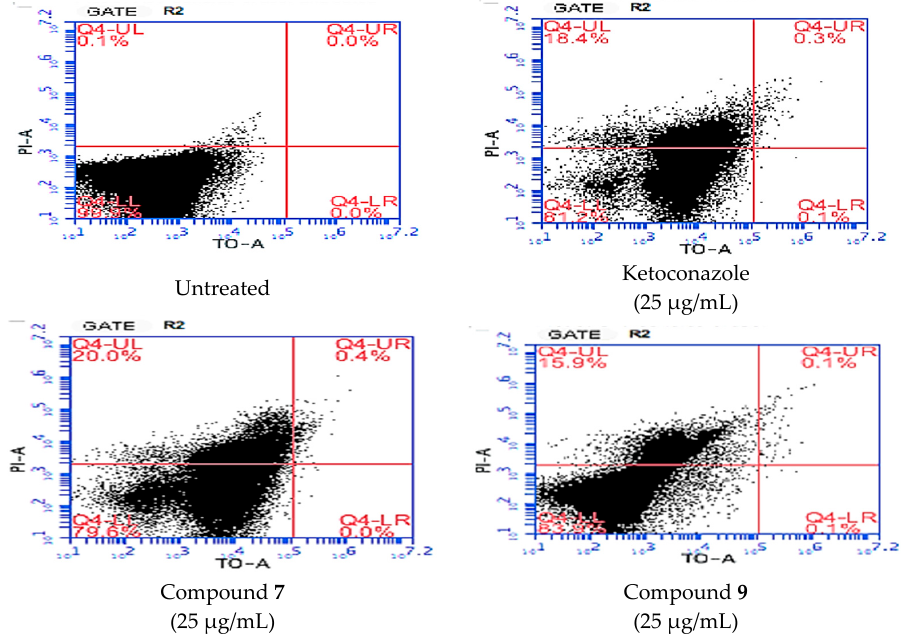
Figure 4. Flow cytometry analysis of C. krusei treated with compounds 7 and 9 . TO: Thiazole orange, PI: propidium iodide. Untreated sample was used as a control and gated according to the untreated yeast.